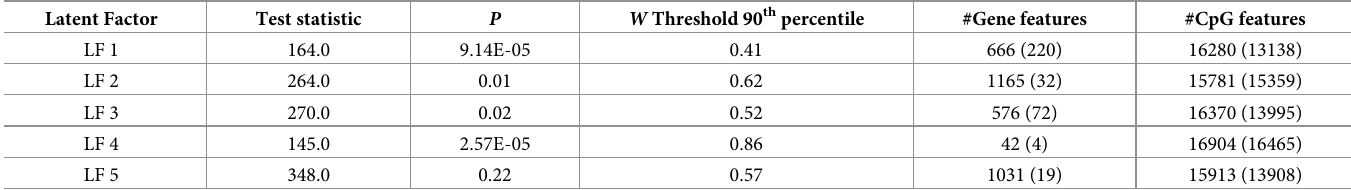
Table 3. Latent factors and threshold for further selection.